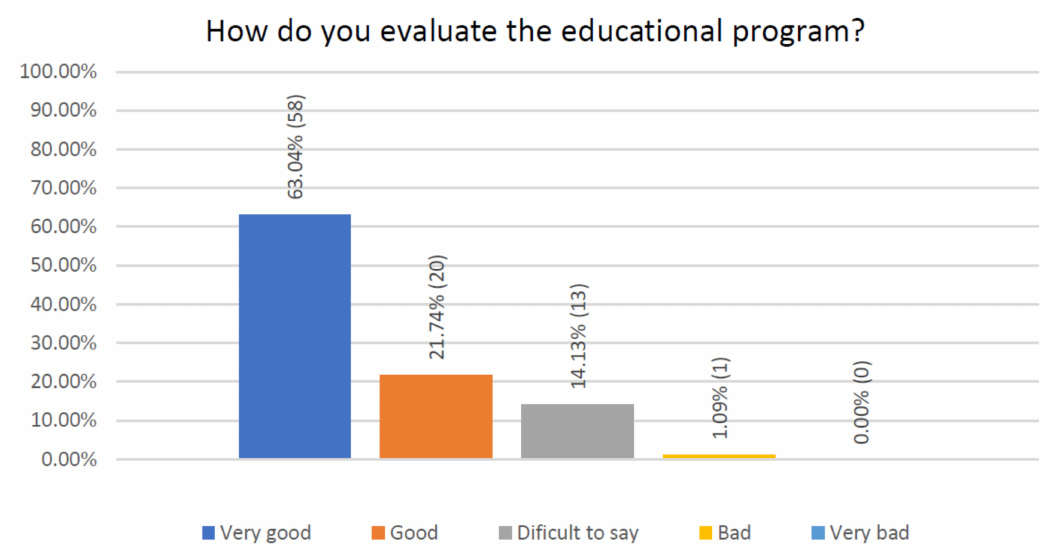
Figure 11. Satisfaction assessment after coordination of the educational prescribed